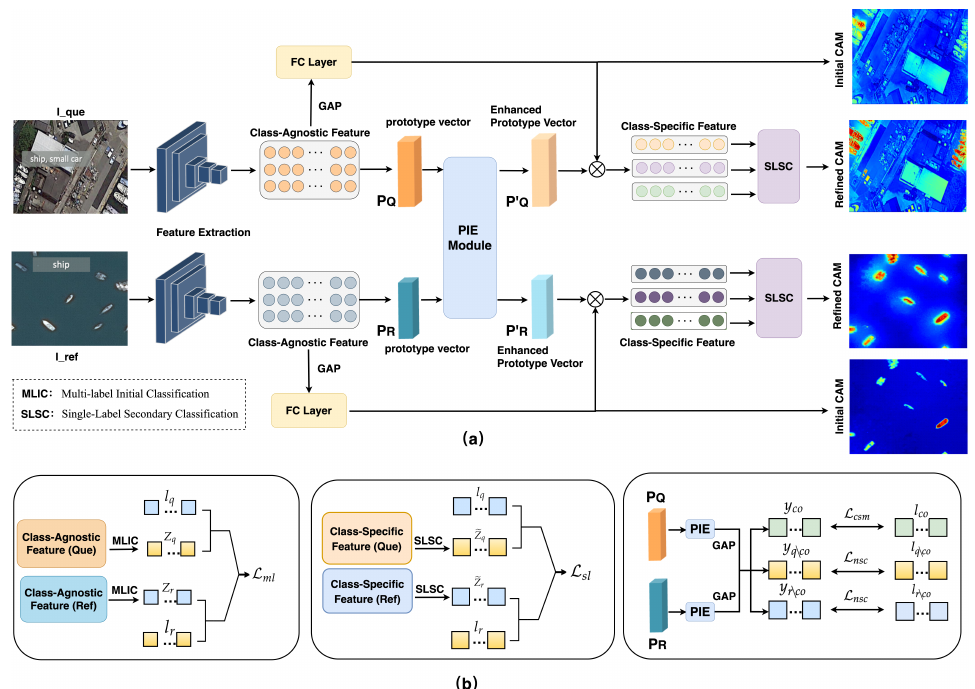
Figure 1. ( a ) An overview diagram of the WSSS cross-image semantic mining (CISM) framework. For a pair of query and reference images containing common classes as the network input, then enhancing the feature representation by exploring prototype vectors to generate class-specific features. ( b ) The schematic diagram of the all loss functions. The basic multi-label soft margin classification loss L ml is used to provide the rough localization of objects. L sl , L csm , and L nsc are three novel losses to assist in the training of the